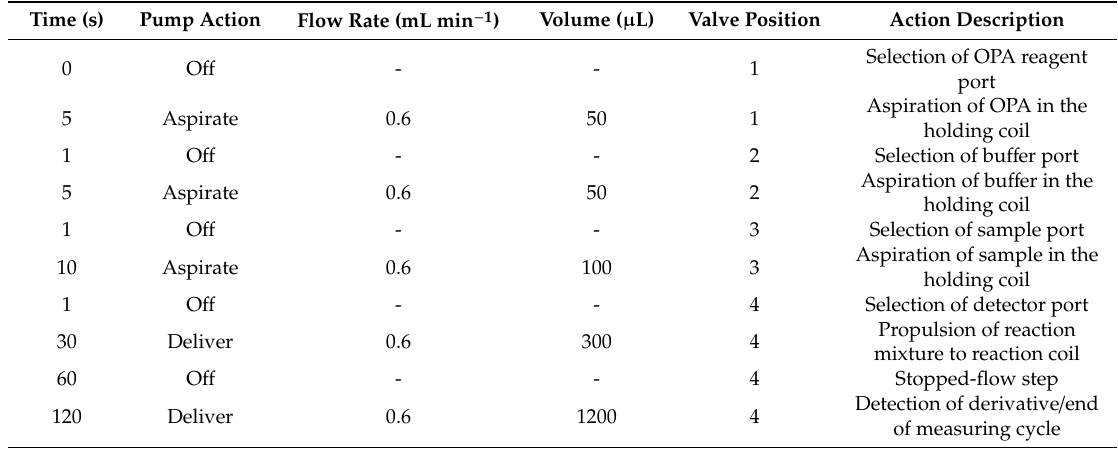
Table 6. ZF steps for the determination of